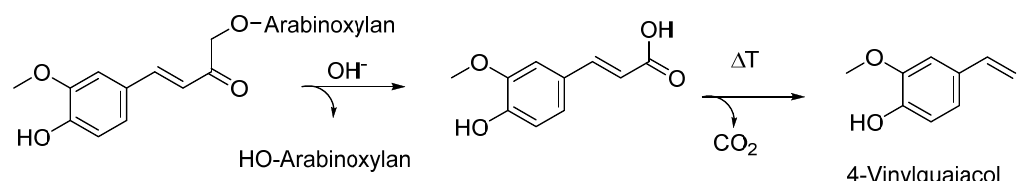
Figure 5. Formation of 4-vinylguaiacol from arabinoxylans during soft pretzel production [38].